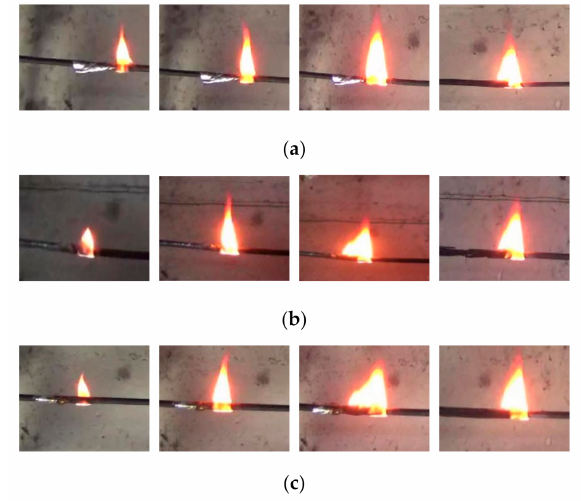
Figure 3. Typical flame shape of a single cable with di ff erent core number (flame spreading from left to right). ( a ) The flame shape of two-cores cable; ( b ) the flame shape of three-cores cable; ( c ) the flame shape of four-cores